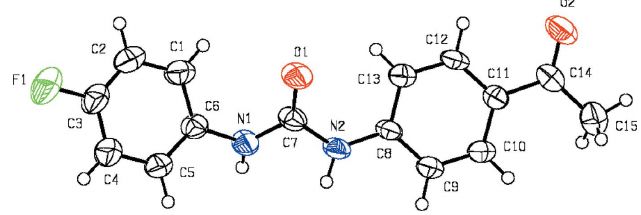
Figure 1 The molecular structure of the title compound, showing the displacement ellipsoids drawn at the 50% probability level.